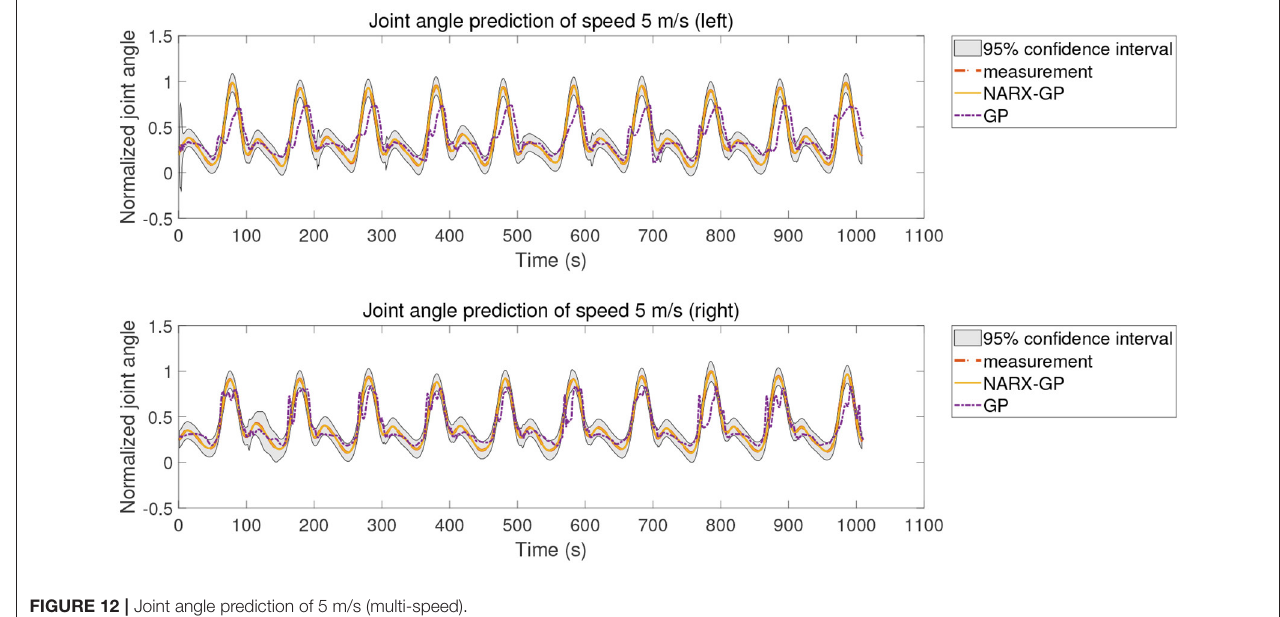
FIGURE 12 | Joint angle prediction of 5 m/s (multi-speed).